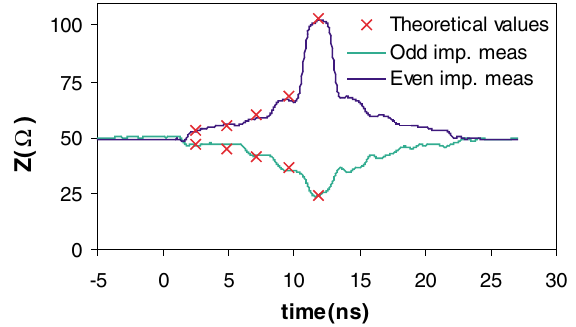
FIG. 10. (Color) Z and Z measured in the final coupler as odd even a function of the time (i.e., position along the line). Measurements from the second half of the structure are not valid because of reflections.